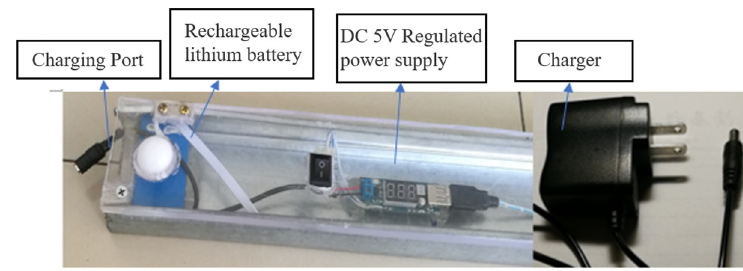
Figure 6. Physical drawing of power